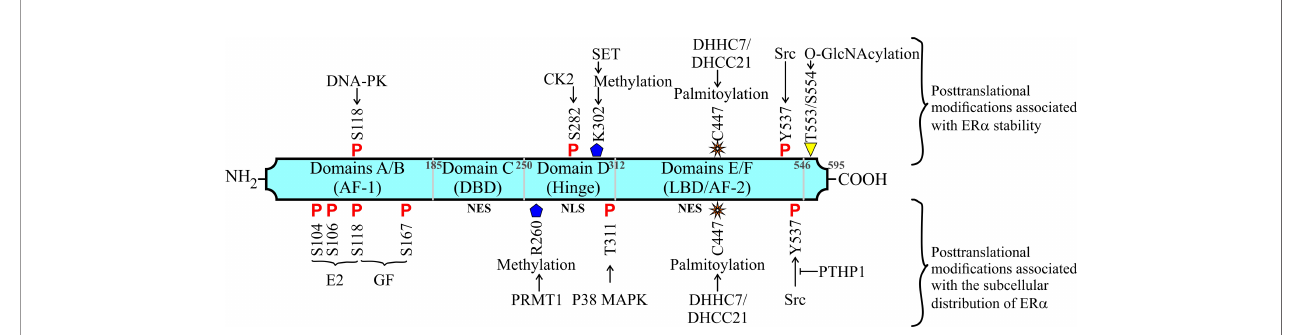
FIGURE 2 | Other posttranslational modi fi cations related to subcellular transport and stability of ER a in breast cancer. Structure of ER a protein and its functional domains. Up: Modi fi cations related to ER a stability. Down: Modi fi cations involved in the subcellular transport in breast cancer